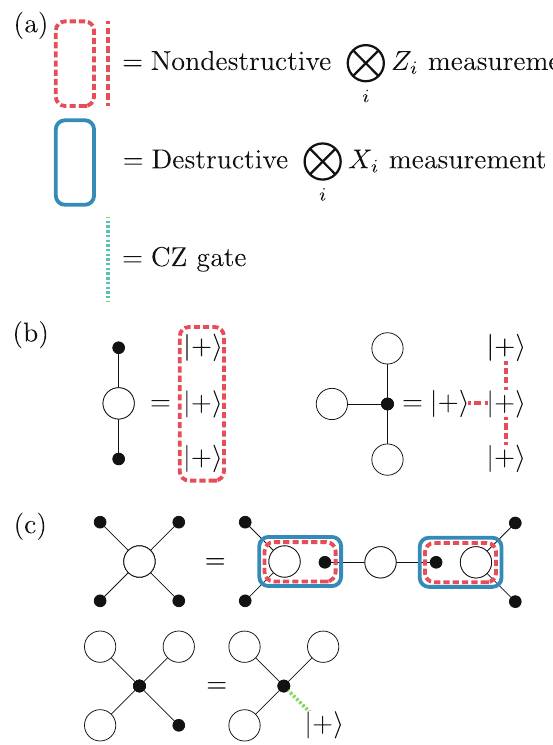
Fig. 6 Building the XZZX cluster state with simple bias-preserving operations. a The XZZX cluster state can be built from a product of þj i states using only nondestructive Z 1 ⊗ Z 2 and Z 1 ⊗ Z 2 ⊗ Z 3 measurements, destructive X 1 ⊗ X 2 measurements, and CZ